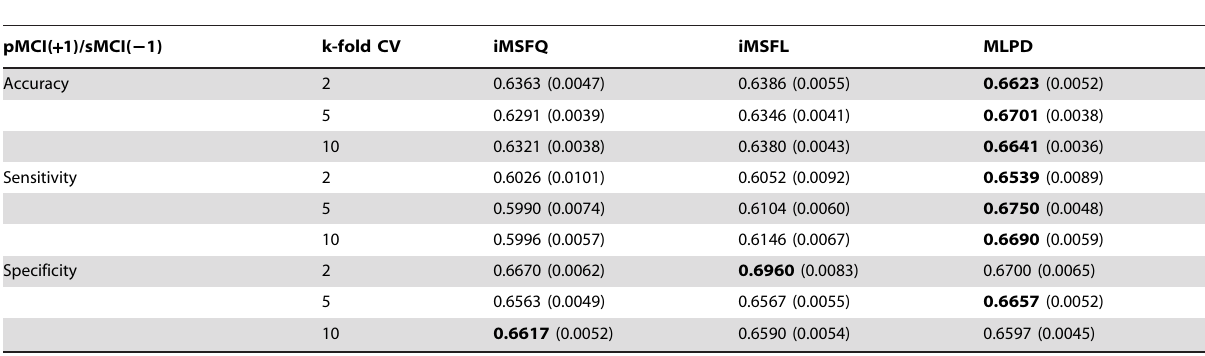
Table 3. Comparison of the classification performance of MLPD and iMSF on task